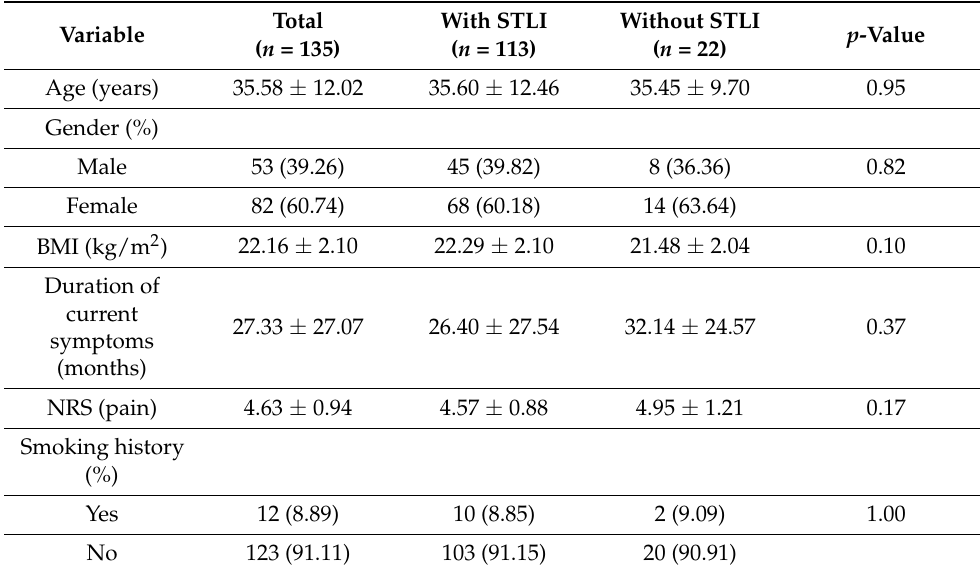
Table 2. Demographic characteristics of participants.